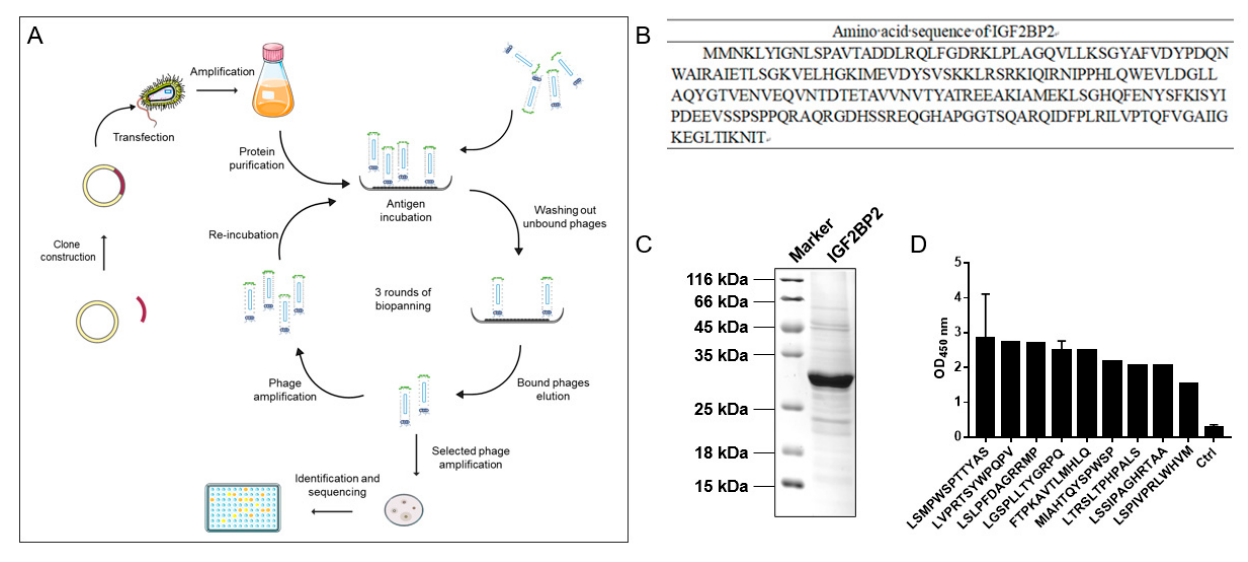
Figure 2. Identification of IGF2BP2-targeted peptides. ( A ) A flow chart for screening of IGF2BP2-targeted peptides. ( B ) Amino acid sequence of IGF2BP2 protein. ( C ) Coomassie brilliant blue staining of IGF2BP2 protein after expression and purification. ( D ) The binding affinities of the nine selected phages. The OD values were analyzed by phage ELISA. Standard deviations appeared in some columns because some repeated sequences appeared several times.